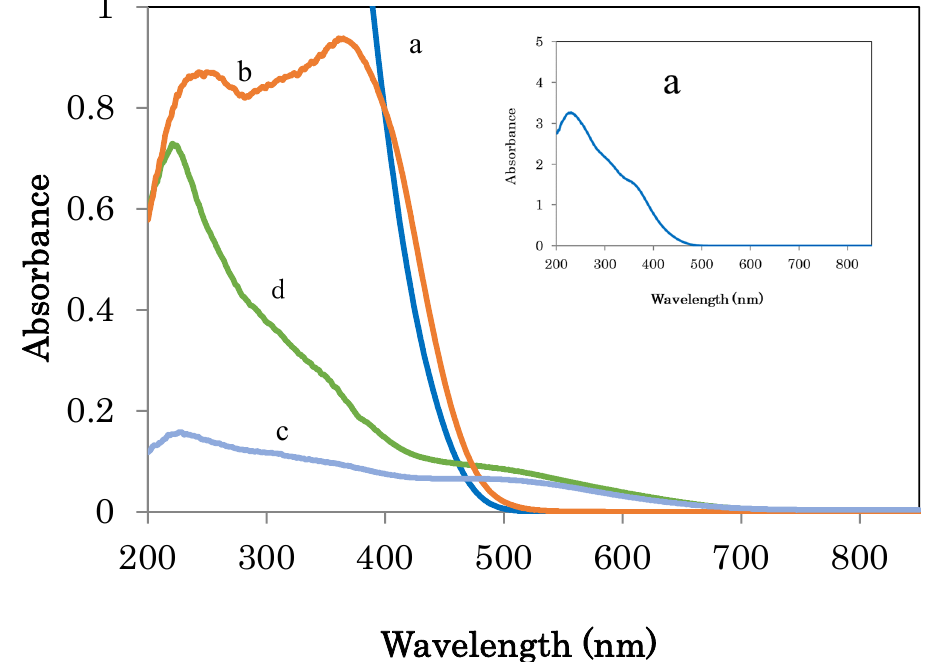
Figure 4. UV-visible spectra of ( a ) ZnIn 2 S 4 , ( b ) Zn 0.87 In 2 S 3.87 , ( c ) Zn 0.87 Cu 0.13 In 2 S 3.935 and ( d ) Zn 0.74 Cu 0.13 In 2 S 3.805 .